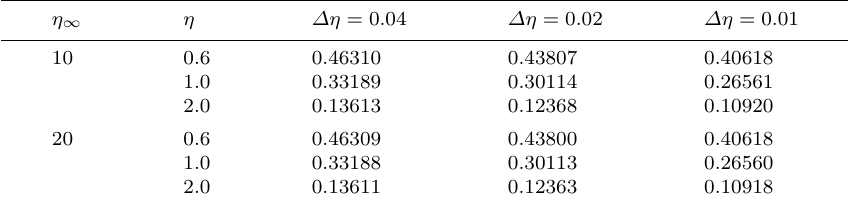
Table 6. Grid-invariance test for temperature profile.